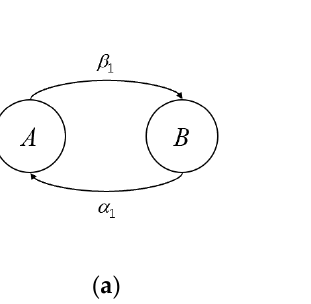
Figure 2. Collaborative development of information granules with different impact factors. ( a ) Design of information granules A and B ( b ) Design of information granules A , B , and C.